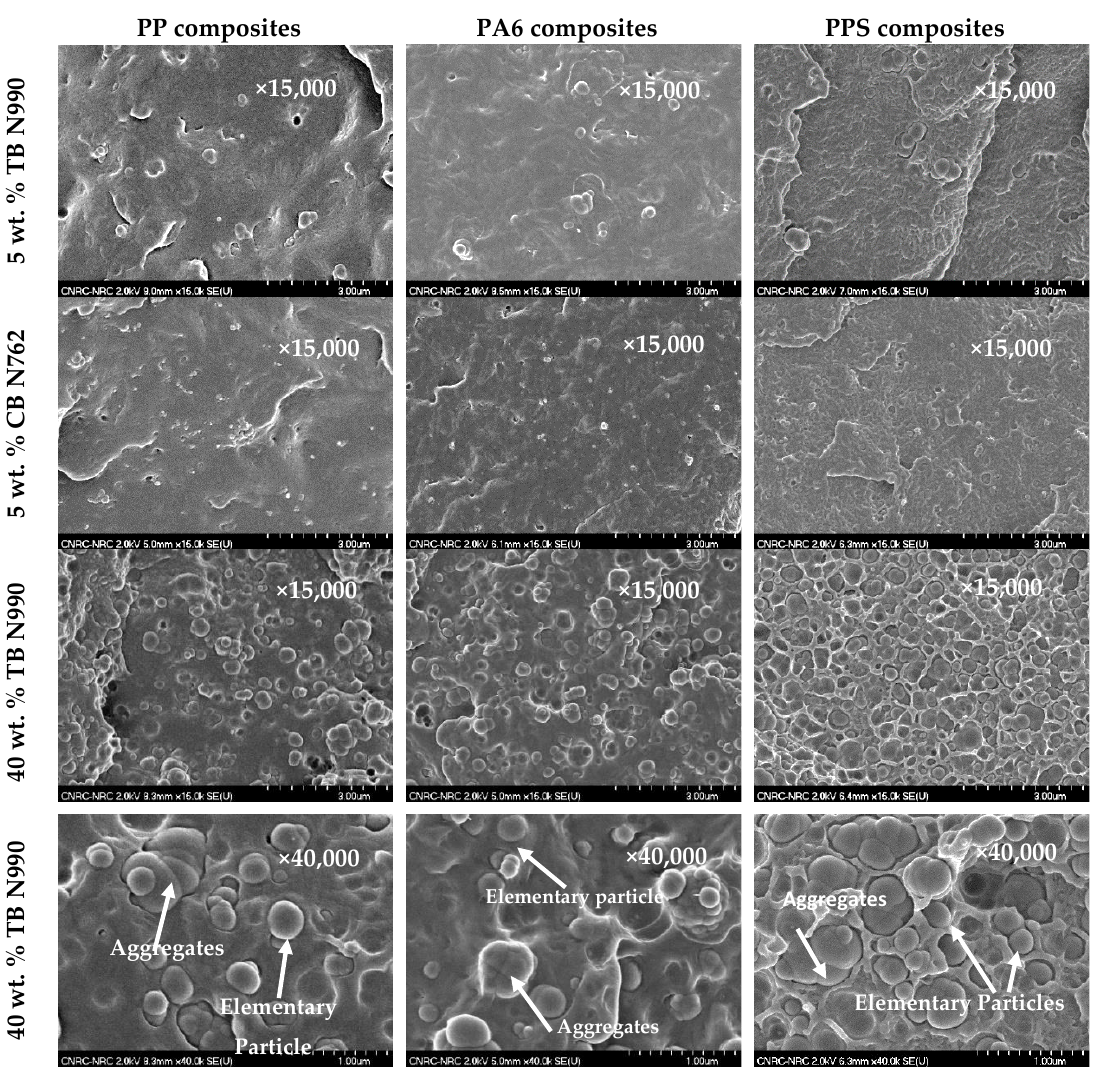
Figure 3. SEM micrographs of PP, PA6, and PPS compounds containing 5 wt. % TB N990 (1st row), 5 wt. % CB N762 (2nd row), and 40 wt. % TB N990 (3rd and 4th rows).